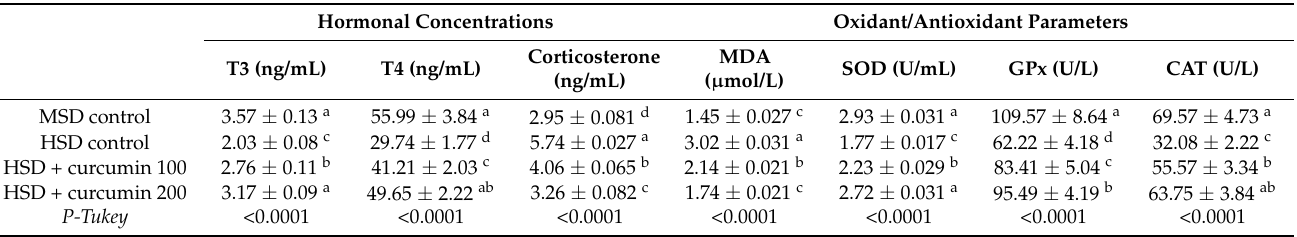
Table 8. Effect of curcumin on hormonal concentrations and oxidant/antioxidant parameters in the serum of broilers reared under high stocking